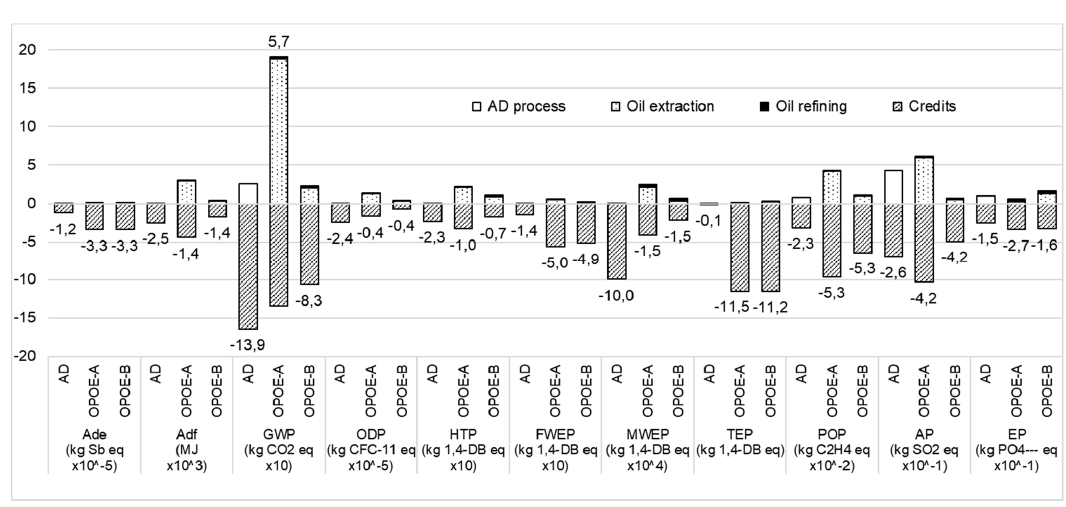
Figure 2. Life cycle environmental impacts of olive mill solid waste valorization via anaerobic digestion and olive pomace oil extraction. AD: anaerobic digestion; OPOE-A: crude olive pomace oil extraction with natural gas as fuel for olive pomace drying; OPOE-B: crude olive pomace oil extraction with extracted pomace as fuel for olive pomace drying. The values shown on top of each bar represent the total impact after the system credits have been applied. Some impacts have been scaled to fit. To obtain the original values, multiply by the factor shown on the x-axis for the relevant impacts.